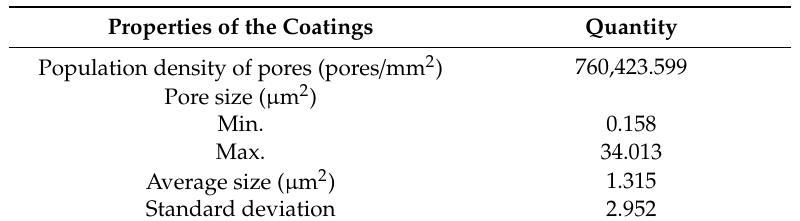
Table 2. Surface characteristics of the coatings.